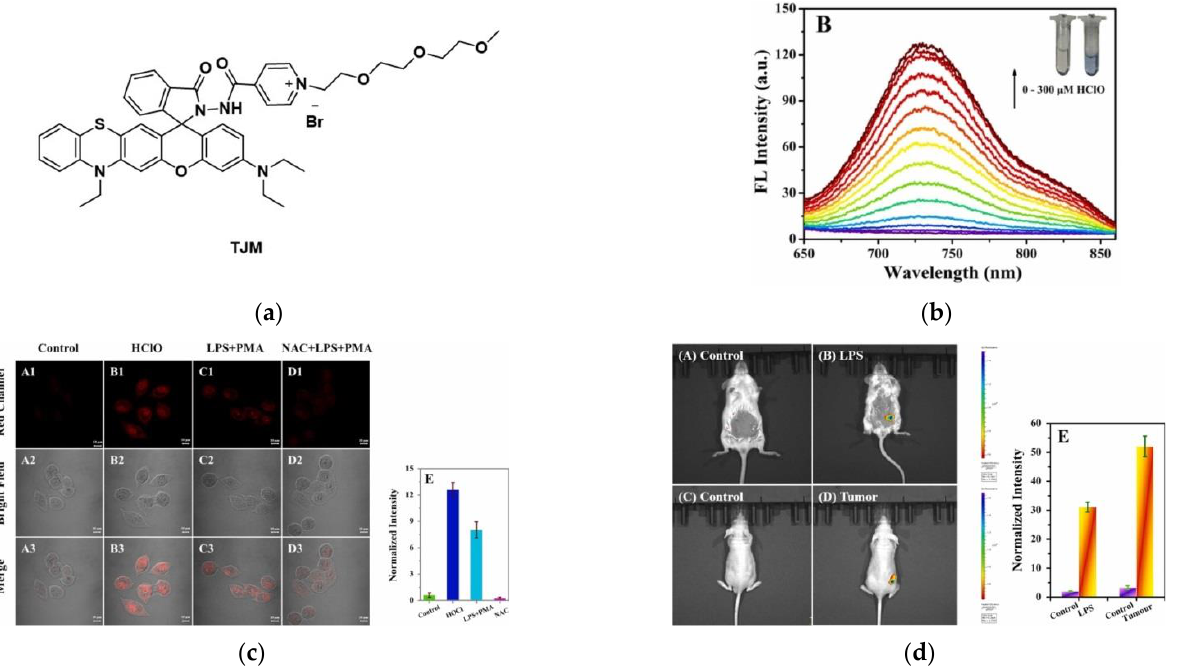
Figure 36. ( a ) Structure of probe TJM; ( b ) Fluorescence spectra of TJM; ( c ) Fluorescence imaging of HeLa cells; ( d ) Fluorescence imaging of mice. Reproduced with permission from [155]. Copyright 2022 Elsevier B.V.